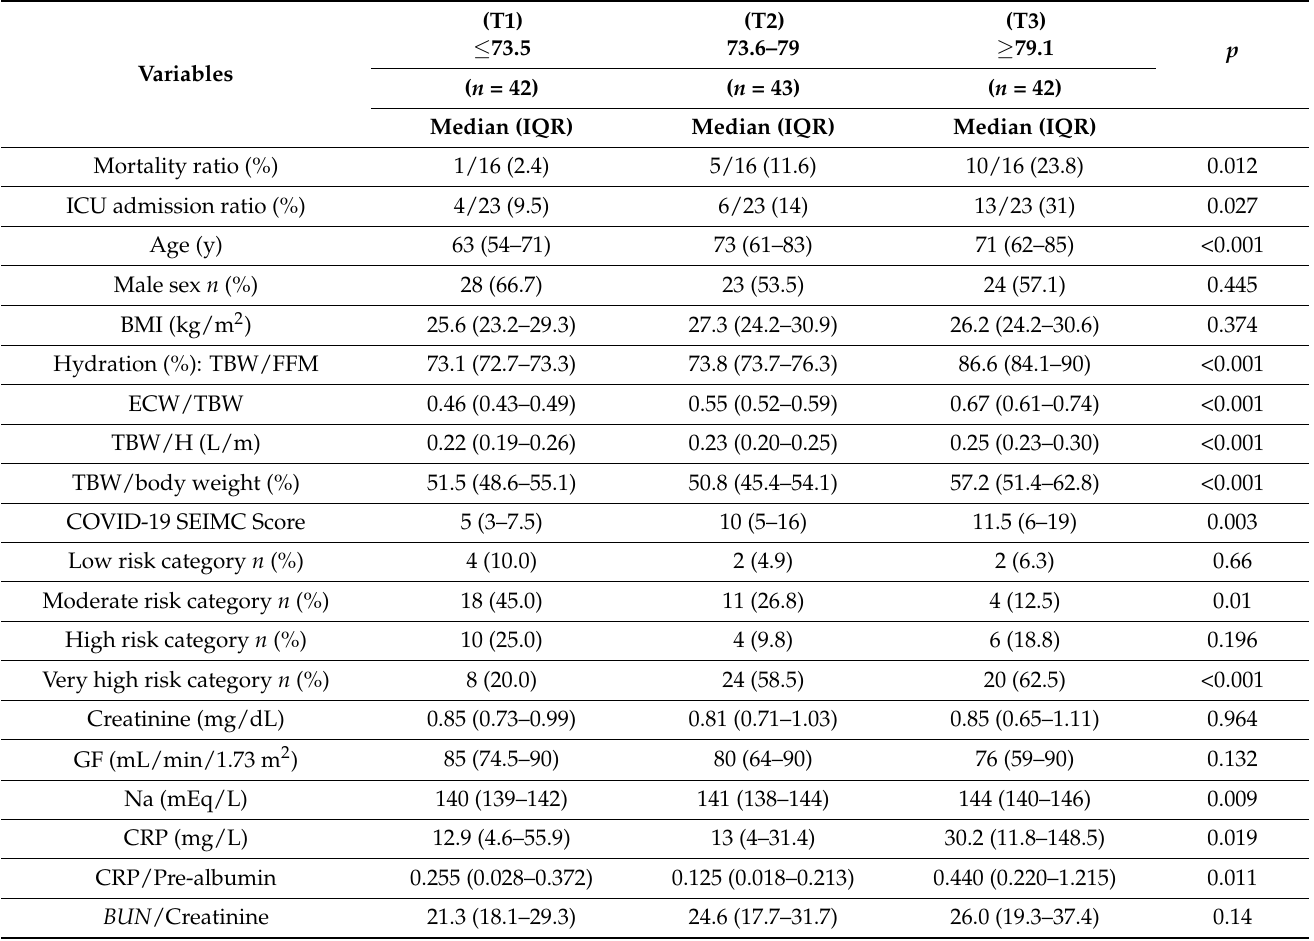
Table 2. Characteristics of COVID-19 patients according to tertiles of hydration status (percentage